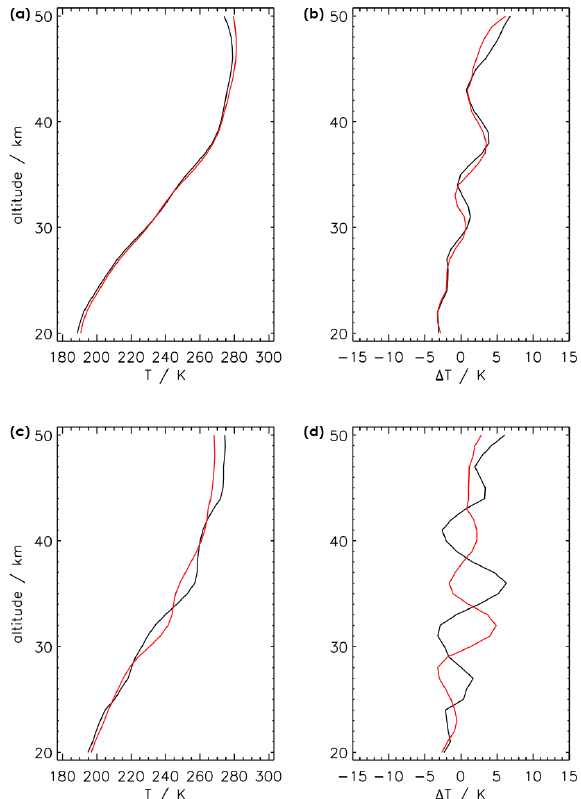
Figure 10. (a, c) ECMWF ERA-Interim (red) and retrieved (black) temperature profile at 67.3 ◦ S, 32.5 ◦ W on 24 September 2009 (a, b) and at 62.0 ◦ S, 5.6 ◦ W on 5 September 2009 (c, d) . (b, d) Differ- ences in profiles, with a smoothed version of the profiles in the left panels, obtained with a boxcar smoothing of 10km width, display- ing the wave structure of the original profiles. MIPAS and ECMWF profiles agree well with respect to the wavelength and amplitude of the temperature waves but not always with respect to the